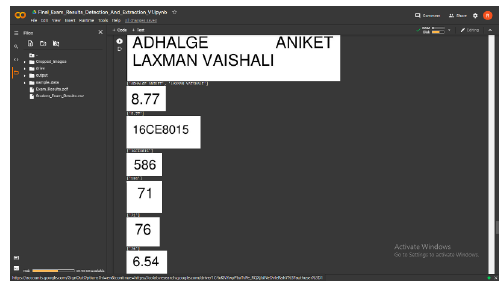
Figure 6. OCR Output